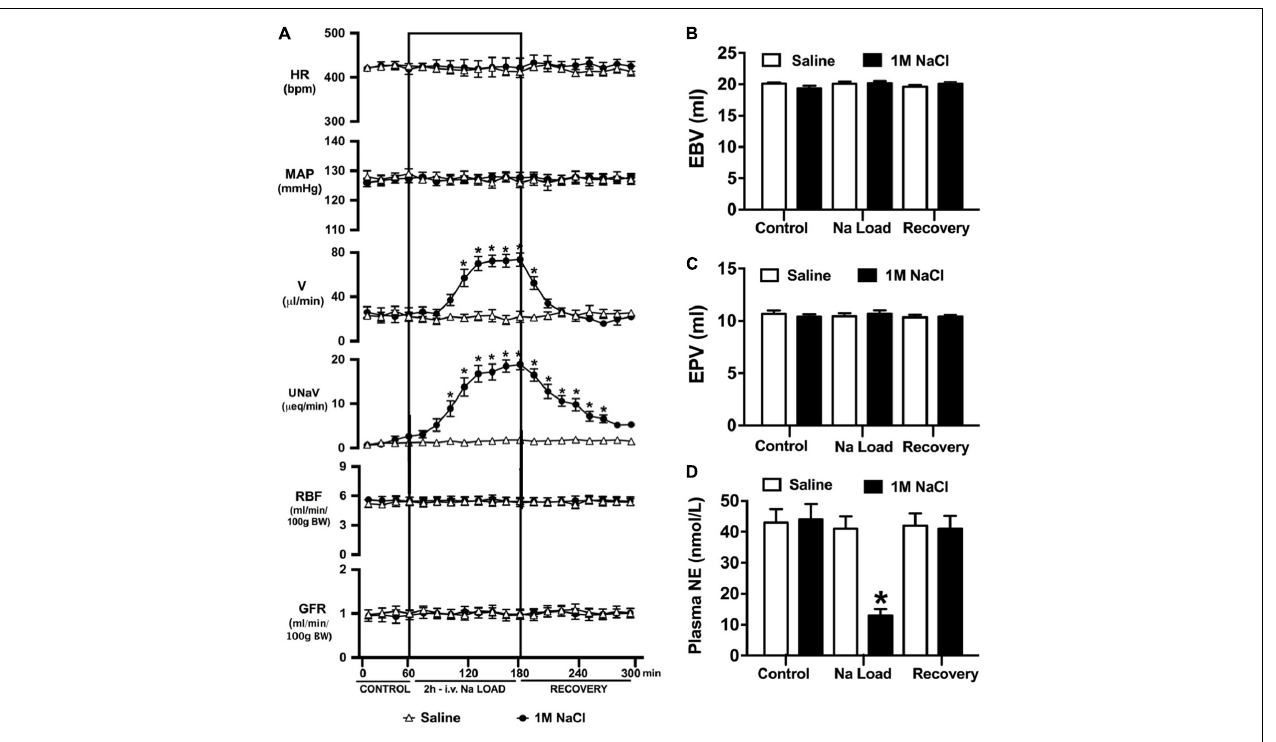
FIGURE 1 | Cardiovascular and renal responses to an acute 1M NaCl infusion (A) Cardiovascular and renal responses, (B) Estimated blood volume (ml), (C) Estimated plasma volume (ml), and (D) Plasma norepinephrine content (nmol/L) during a 1-h control isotonic saline infusion (20 µ l/min), a 2-h 1M NaCl infusion (20 µ l/min) and a 2-h recovery period of isotonic saline infusion (20 µ l/min) in conscious male Sprague Dawley rats. HR = heart rate (bpm), MAP = mean arterial pressure (mmHg), V = urinary flow rate ( µ L/min), UNaV = urinary sodium excretion ( µ eq/min), GFR = glomerular filtration rate [ml/min/100g body weight (BW)], RPF = estimated renal plasma flow (ml/min/100 g BW). Data are presented as mean ± SEM, N = 6/group. * p < 0.05 vs. group baseline value in last 15-min of the control saline